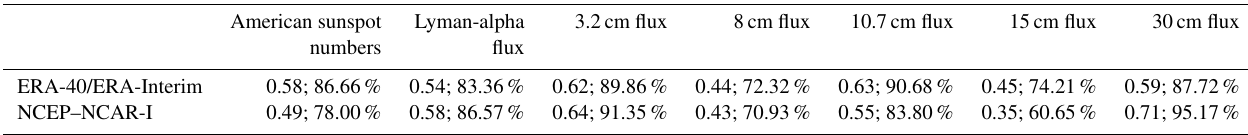
Table 1. Values of the correlation coefficient between solar activity and MSSWs for different proxies. The number of subintervals is the same for all